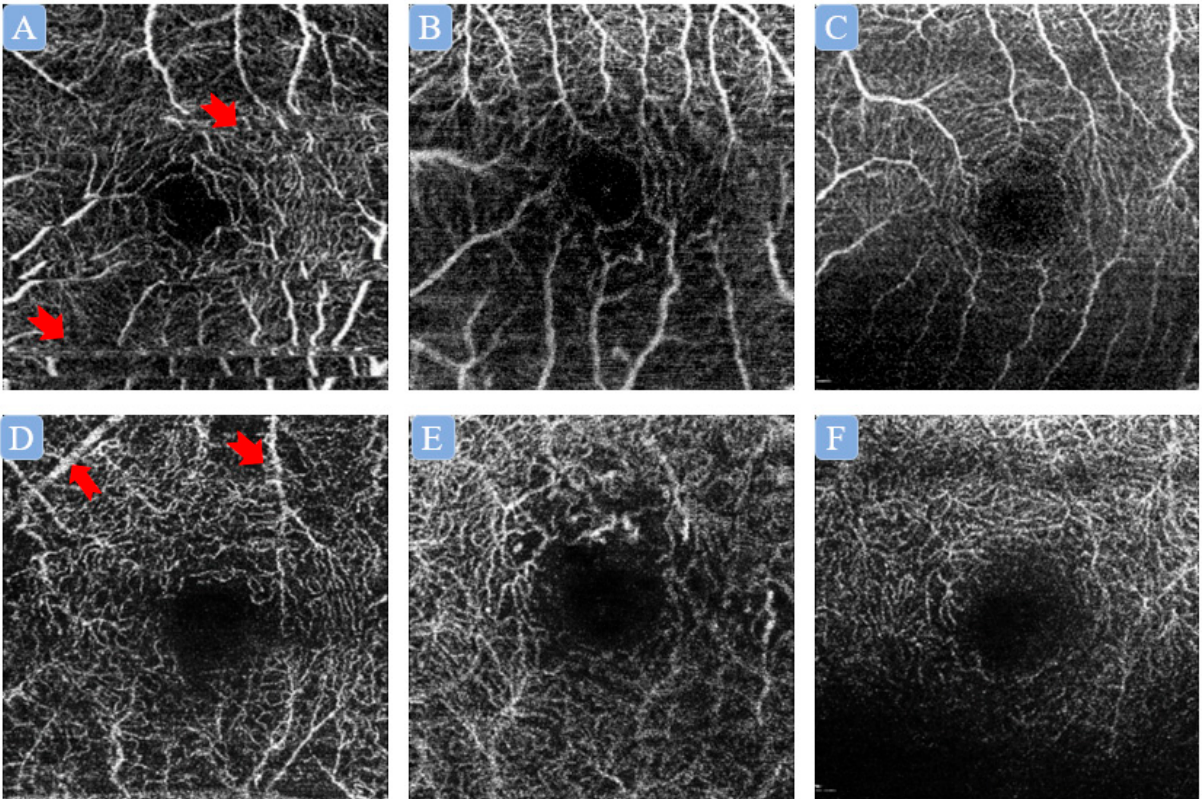
Figure 2. Illustration of different kinds of artifacts in superficial capillary plexus (SCP) and deep capillary plexus (DCP) optical coherence tomography angiography (OCT-A) images. ( A – C ) Artifacts in SCP OCT-A images, namely, ( A ) movement artifact (red arrow); ( B ) defocus artifact; ( C ) shadow artifact. ( D – F ) Artifacts in DCP OCT-A images, namely, ( D ) projection artifact (red arrow); ( E ) defocus artifact; ( F ) shadow artifact.